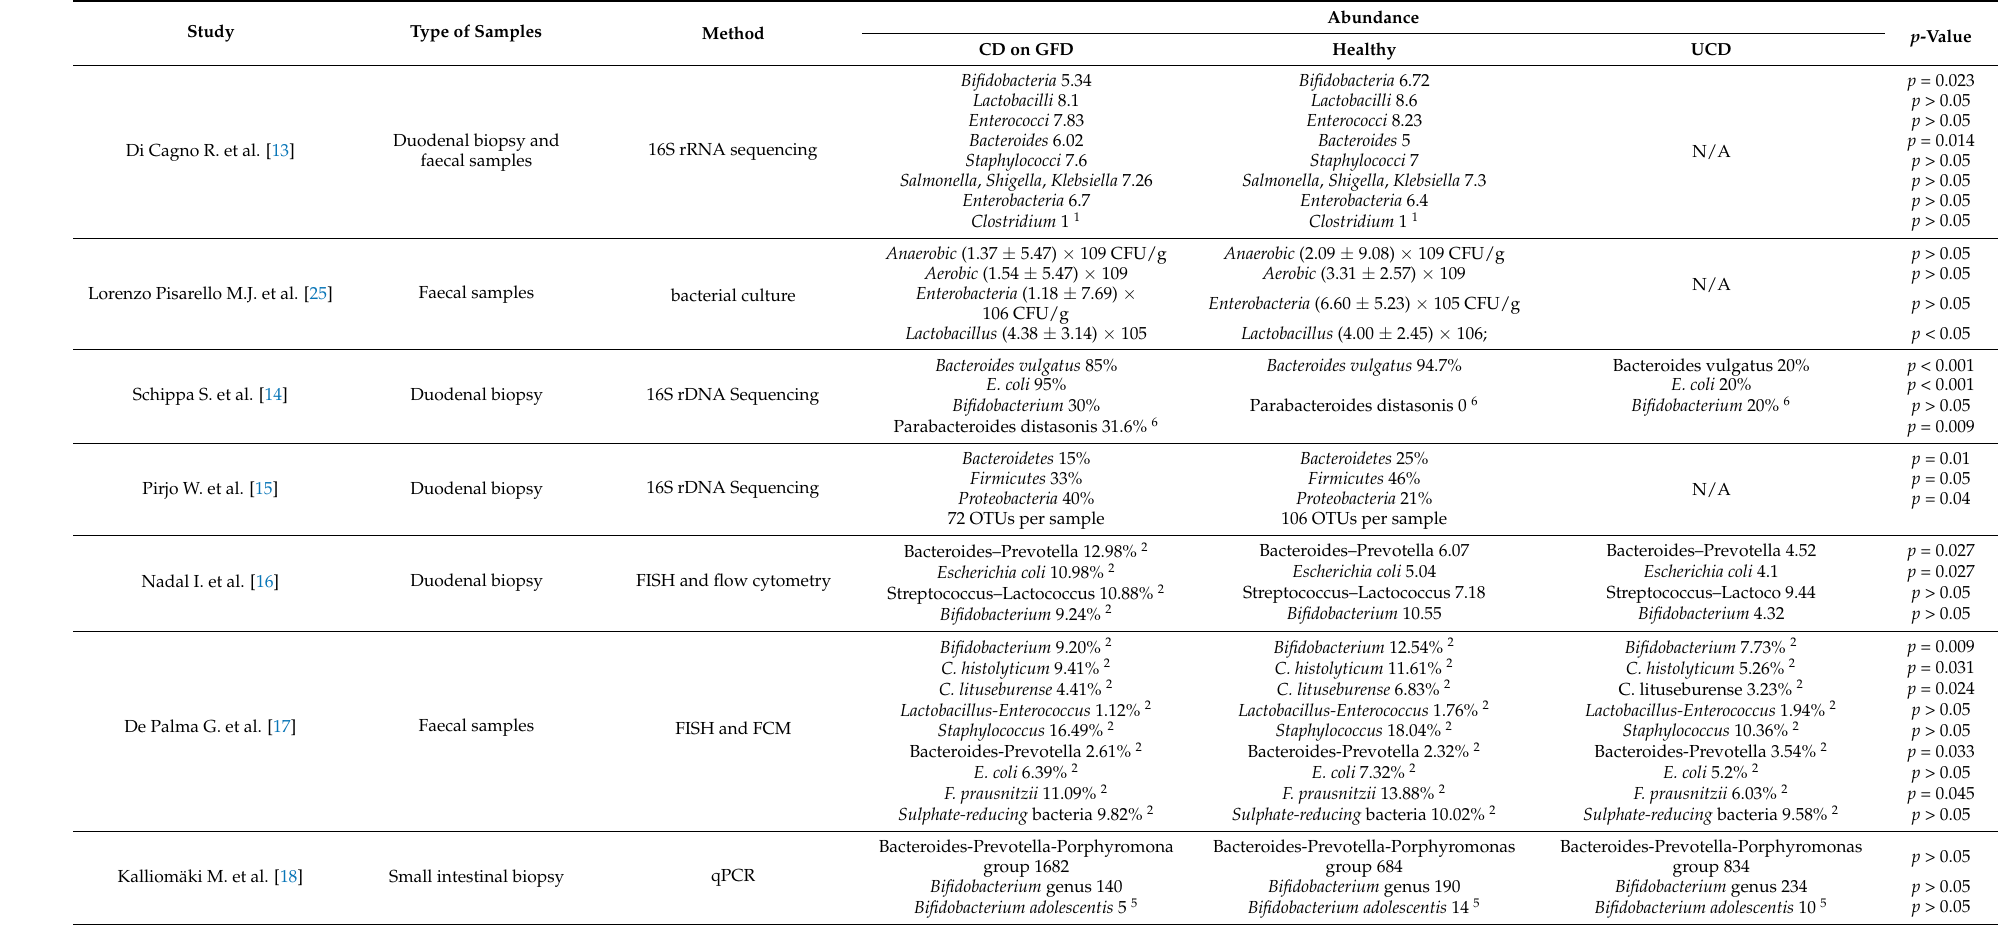
Table 3. Gut microbiota diversity based on GFD application in CD